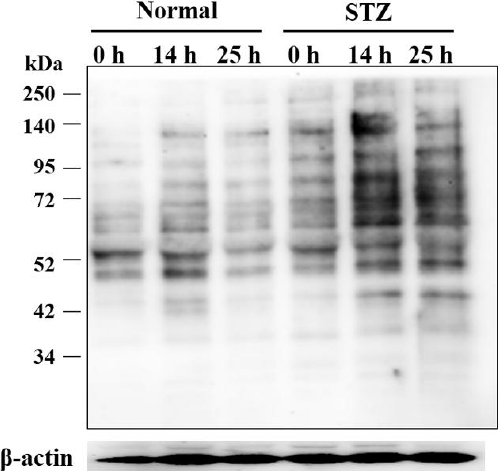
Figure 6. Hematoxylin and eosin staining of the cornea in normal and STZ rats 25 h after corneal wound abrasion. ( A ) Corneal epithelial image of normal rats. ( B ) Corneal epithelial image of STZ rats. Arrow ( ▲ ) shows adhesion deficiency between corneal basal cells and Bowman’s membrane.